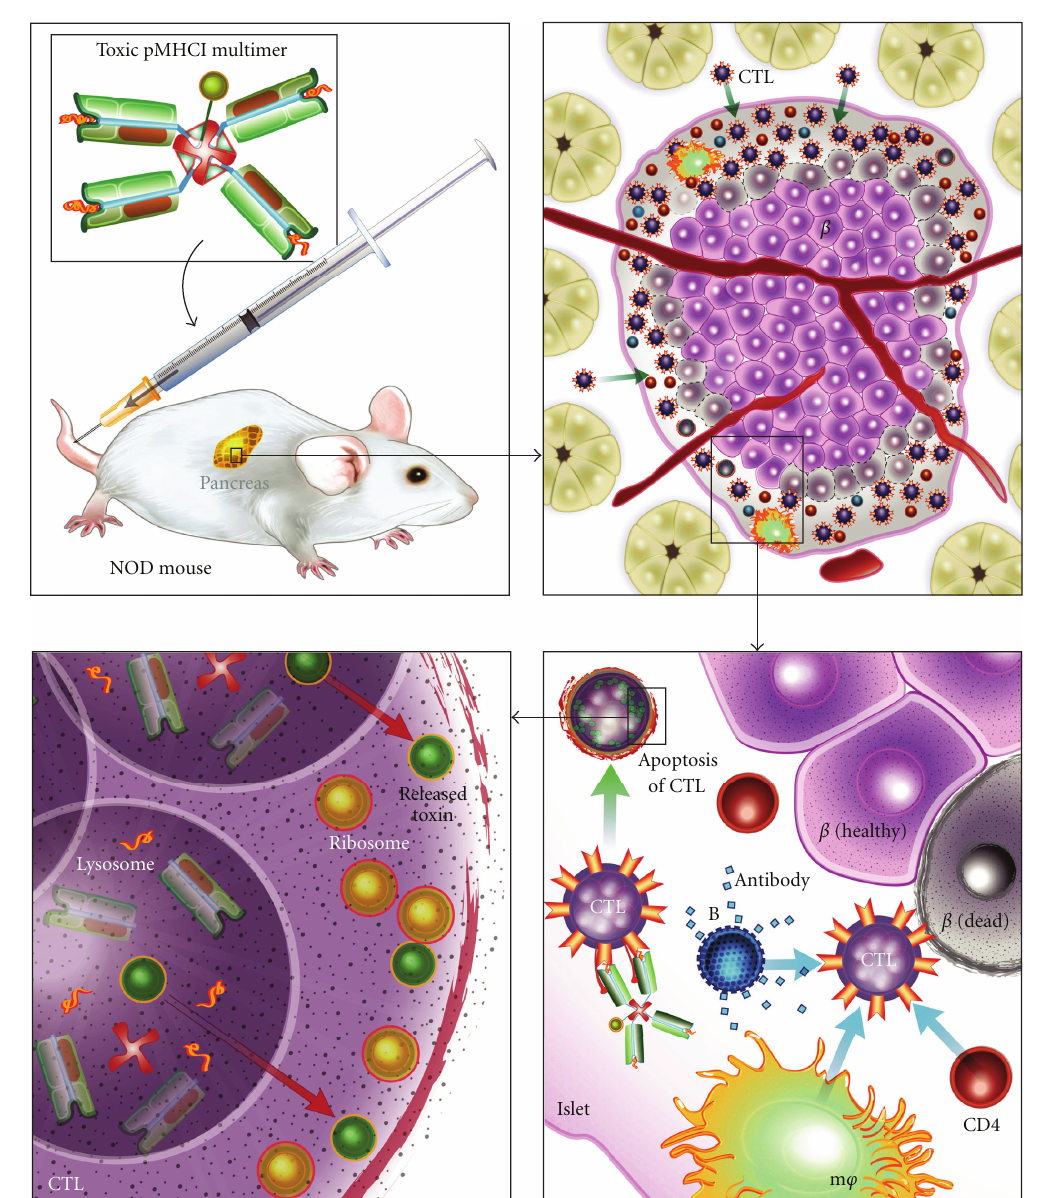
Figure 1: Schematic representation of the e ff ects of toxic pMHCI tetramer administration to NOD mice. Clockwise from upper left: toxic moieties, such as saporin, can be linked to pMHCI multimers that are specific for diabetogenic CTL before being delivered to prediabetic NOD mice. Toxic pMHCI tetramers can access inflamed islets where cognate CTLs are present. Insulitis involves numerous autoreactive immune cell subsets that act in concert to potentiate diabetogenic CTL and destroy β cells. However, pMHCI multimers can deliver saporin to diabetogenic CTL clonotypes and induce apoptosis in an antigen-specific manner. Cognate TCR interacting with saporin-conjugated pMHCI results in uptake of the tetramer into the lysosome of the CTL. In the lysosome, the toxic pMHCI tetramer is disassociated, allowing the freed saporin molecules to escape these organelles. Saporin is a potent ribosome-inactivating toxin that can perform multiple rounds of ribosome disabling, ultimately leading to apoptosis of the CTL and therein preventing further β cell damage by the targeted diabetogenic